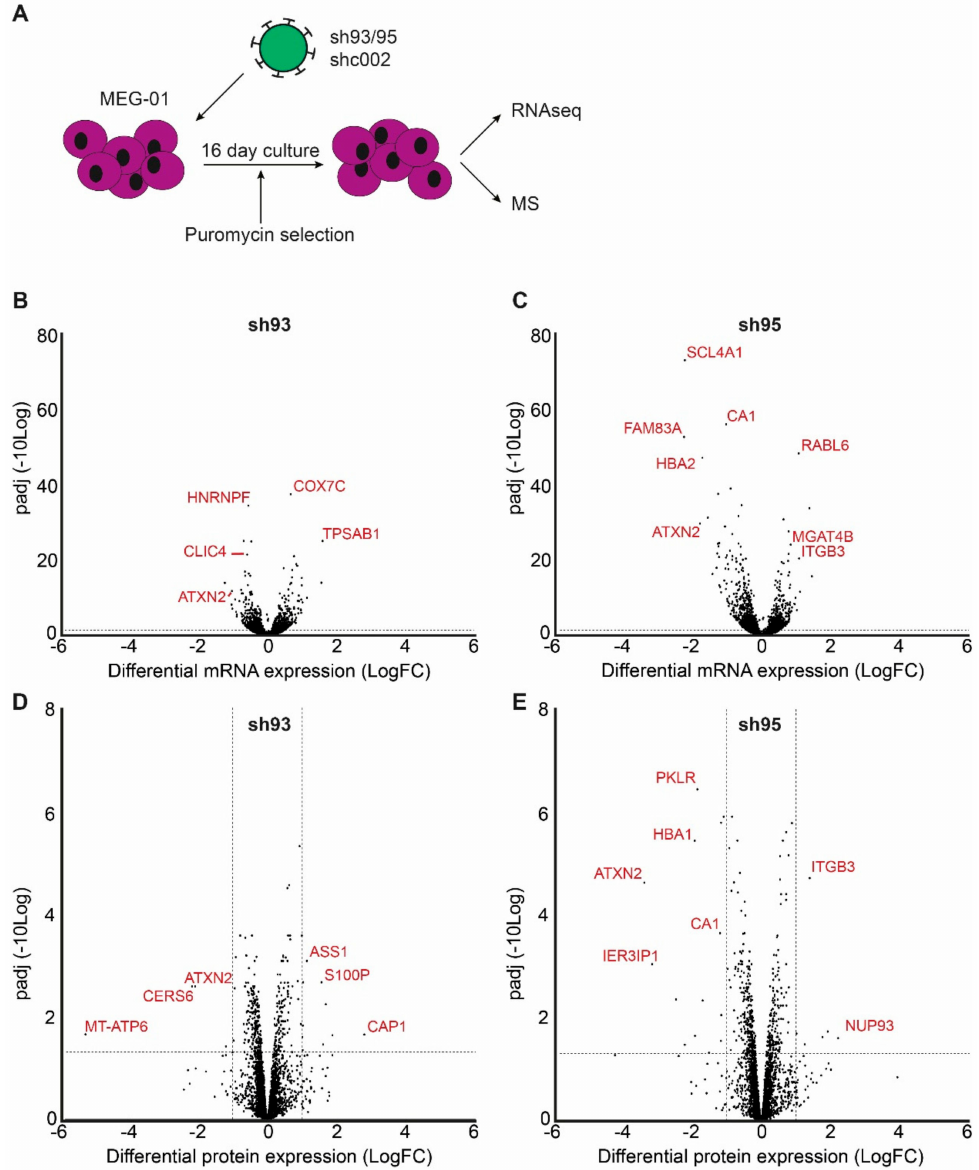
Figure 3. Deregulation of RNA and protein content in MEG-01 cells after ATXN2 depletion ( A ) Schematic representation of MEG-01 transduction with lentiviral vectors expressing shc002 control, or ATXN2 -directed sh93 or sh95 shRNA. Transduced cells were selected for puromycin resistance throughout the culture period. Cells were harvested 16 days post-transduction for parallel RNA sequencing and mass spectrometry analysis. ( B–E ) Di ff erentially expressed genes (FDR < 0,05, n = 3) between shc002 and sh93 ( B , D ) or sh95 ( C , E ) transduced cells were identified on mRNA (B, C) and protein ( D , E ) level. A Di ff erential expression (log2 fold change) is plotted against the adjusted p value (padj transformed as –log10 values). A selection of genes is